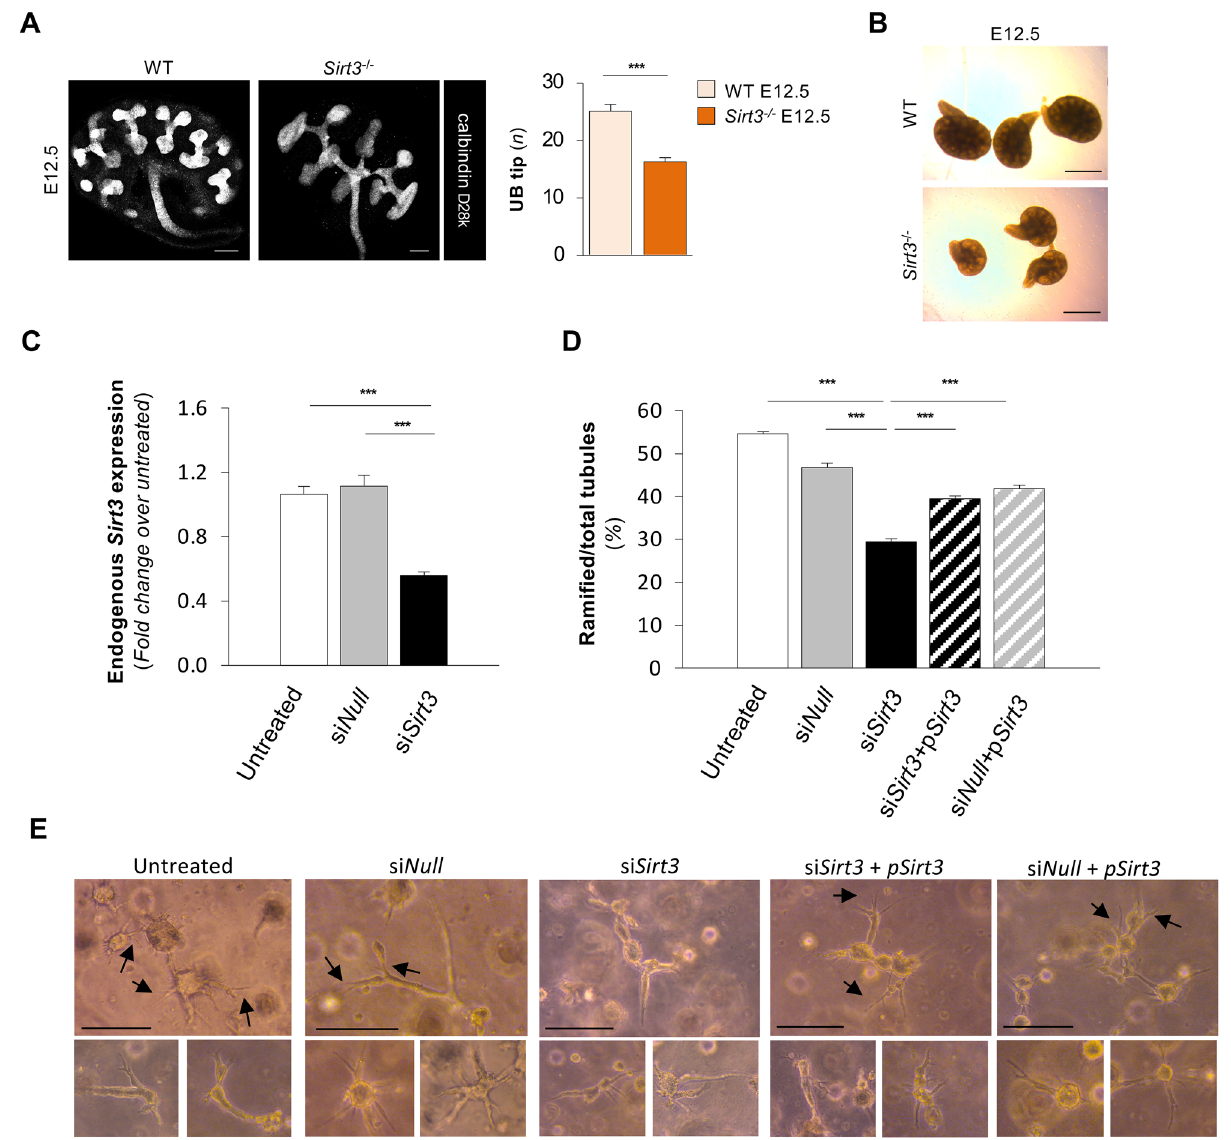
Figure 6. Sirt3 deficiency alters ureteric bud branching in vivo and impairs in vitro tubulogenesis. ( A ) Representative immunofluorescence images of calbindin D28k-positive ureteric bud (UB) trees of E12.5 kidneys (representative of n = 3 mice per group) and quantification of UB tips per kidney in WT and Sirt3 −/− mice on E12.5 ( n = 17, WT and n = 12, Sirt3 −/− mice). Scale bars, 100 μm. ( B ) Representative pictures of kidneys from WT or Sirt3 −/− mice on E12.5 under contrast phase microscope. Scale bars, 500 μm. ( C ) Expression of endogenous Sirt3 mRNA by real-time PCR in untreated mIMCD3 cells, mIMCD3 transfected with a control nontarget small interfering RNA (si Null ), or with a silencer select predesigned small interfering mouse Sirt3 (si Sirt3 ) (n = 3 independent experiments). ( D ) Quantification of mIMCD3 cell-derived ramified tubules per total tubules in untreated, si Null or si Sirt3 cells transfected or not with a vector overexpressing the short Sirt3 isoform (p Sirt3 ). n = 3 samples per group. For each experimental group, the number of total fields analysed were: n = 55 for untreated, n = 50 for si Null , n = 58 for si Sirt3 , n = 53 for si Sirt3 + p Sirt3 , and n = 49 for si Null + p Sirt3 . ( E ) Representative images of tubules formed in a 3D collagen culture system. At 3 days, untreated and si Null cells give rise to complex and ramified tubules, some of which exhibit terminal bifid and trifid branching (arrows). si Sirt3 cells form mainly straight tubules and small round clusters of cells. The ability of tubules to branch was re-stablished in si Sirt3 cells by plasmid-mediated Sirt3 overexpression. Scale bars, 100 μm. Data represent mean ± s.e.m. and were analysed with Student’s t -test or ANOVA corrected with Bonferroni coefficient, as appropriate. *** P <